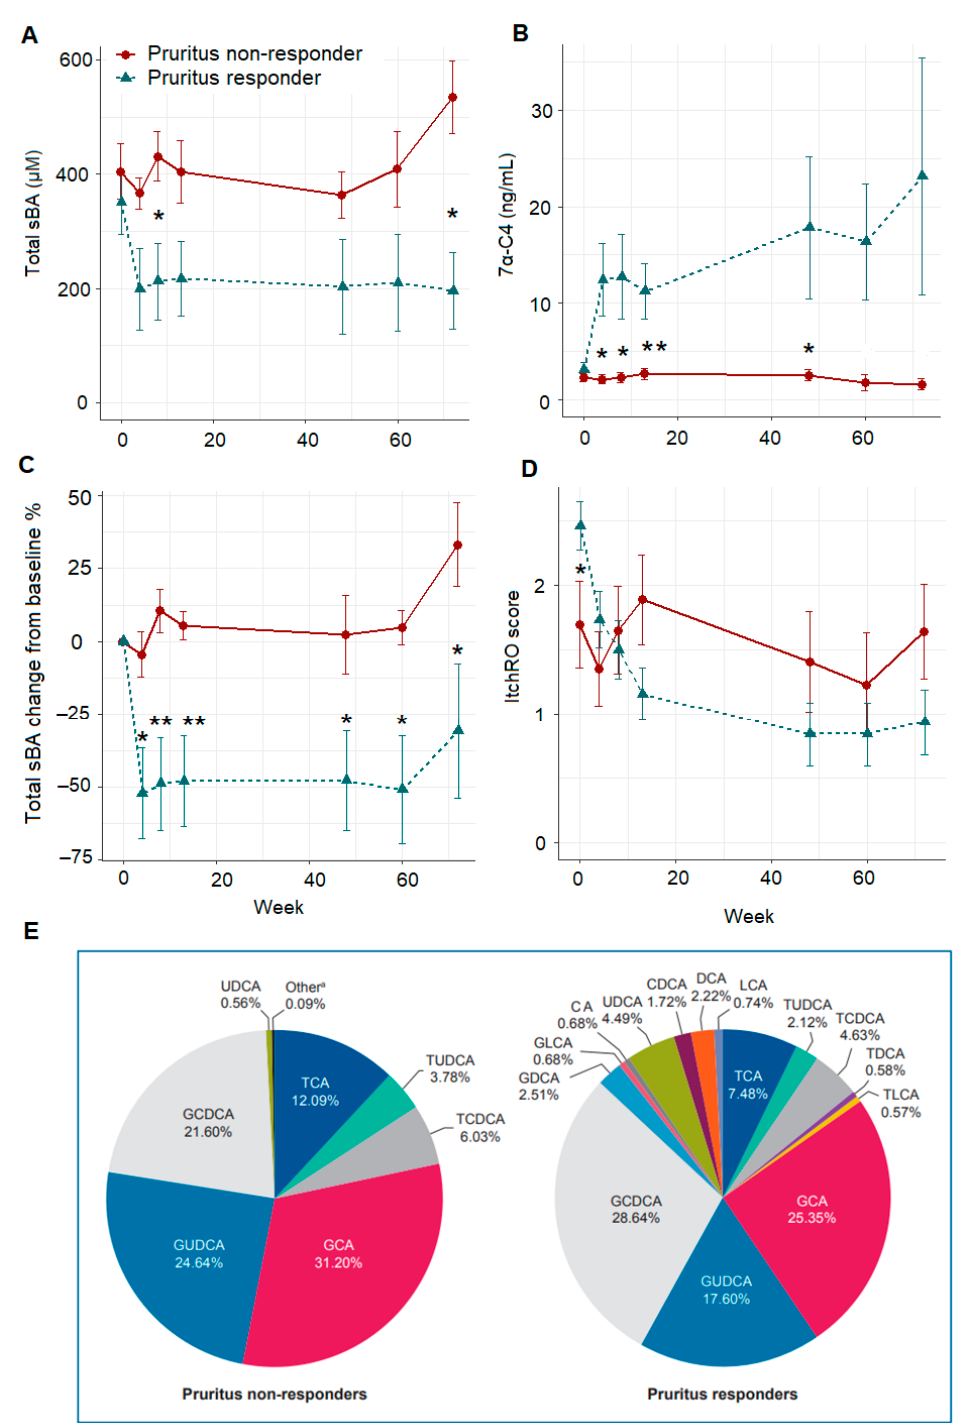
ItchRO(Obs) score (pruritus responders) showed decreased total sBA concentrations com- (Figure 1). After 72 weeks of treatment, PFIC2 patients with an improved ItchRO(Obs) pared with pruritus non-responders (mean, 195.97 ± 202.05 vs. 534.73 ± 155.40 μ M, p = score (pruritus responders) showed decreased total sBA concentrations compared with 0.004). pruritus non-responders (mean, 195.97 ± 202.05 vs. 534.73 ± 155.40 µ M, p = 0.004).